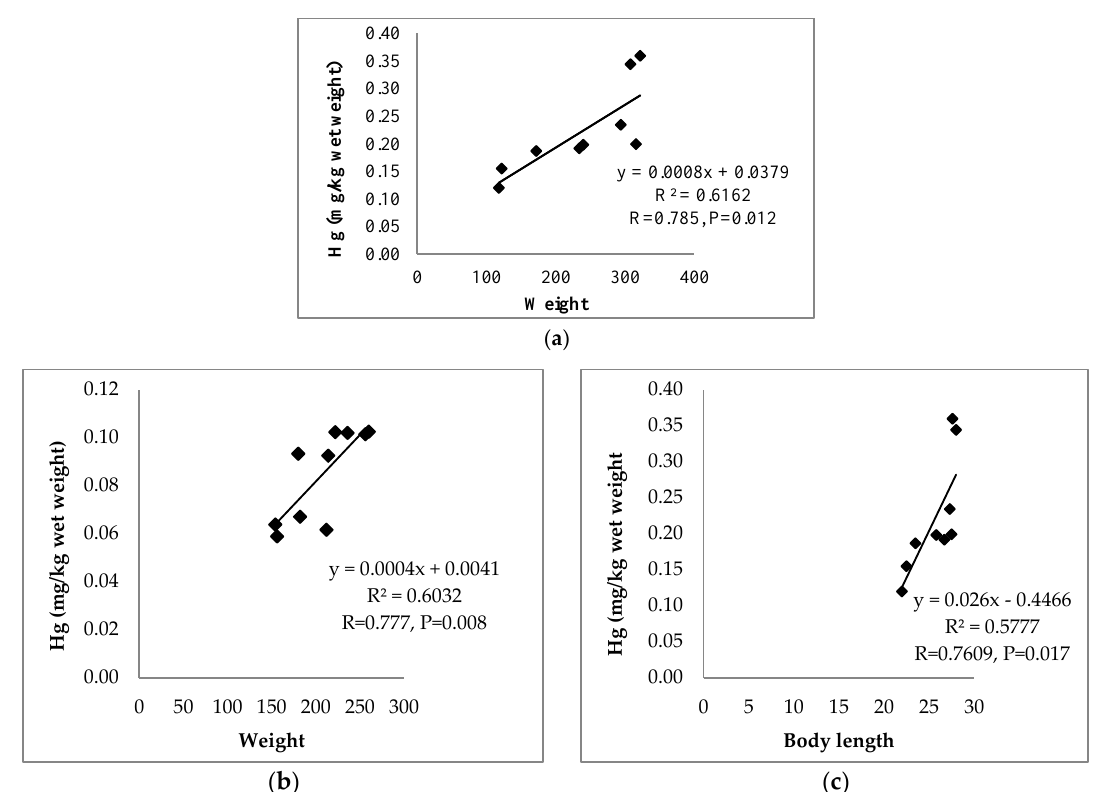
Figure 2. Interspecific differences (Mean ± SD) in the content of mercury in the organs of the same fish species; a, b, c and d, significant difference ( p ≤ 0.05). The same letter indicates the absence of significant differences between organs of the same fish studied.